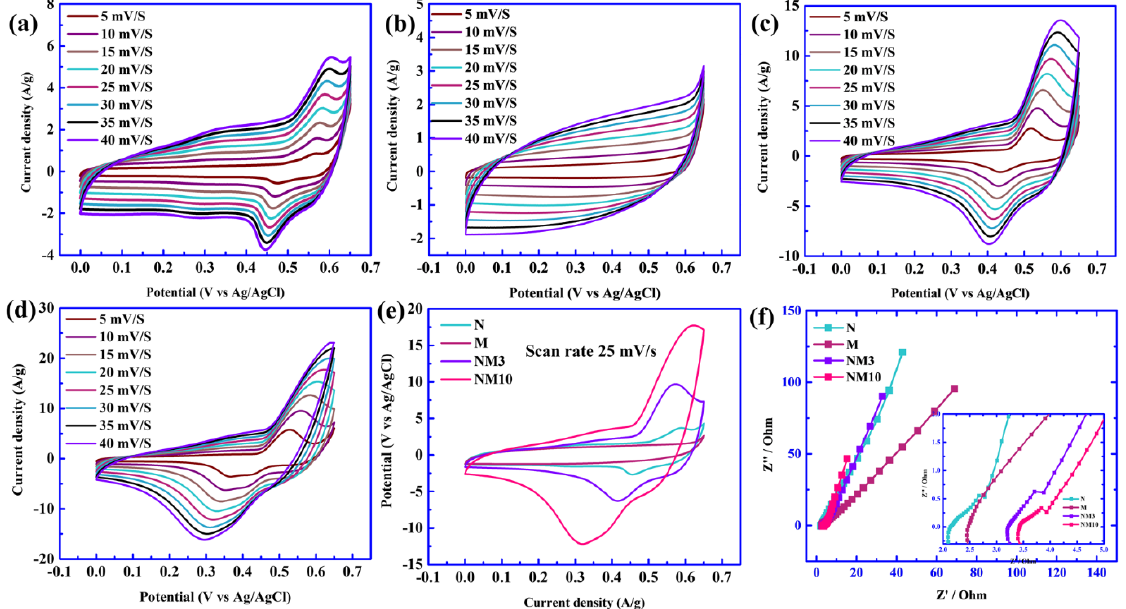
Figure 5. ( a – d ) CV curves of N, M, NM3, and NM10 with different scan rates; ( e ) comparison of CV curves of N, M, NM3, and NM10 with a scan rate of 25 mV/s; ( f ) EIS spectra of N, M, NM3, and NM10 (inside image is an enlarged high-frequency region).